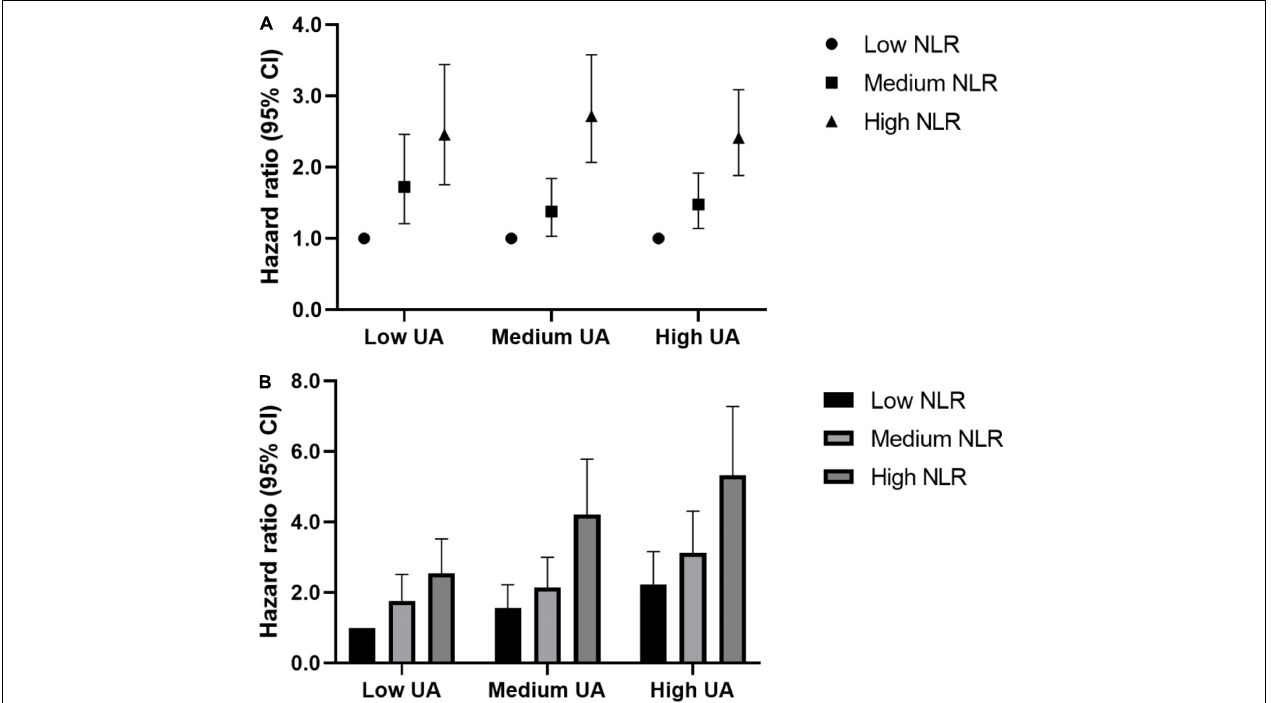
FIGURE 3 | Interaction and joint associations of UA and NLR with ischemic stroke recurrence. Hazard ratios were adjusted for age, gender, hypertension, diabetes, atrial fibrillation, coronary heart disease, HCY, carotid atherosclerosis, TOAST. (A) Multiplicative interaction was evaluated using hazard ratios for the product term between the NLR (low v high) and UA (low v high), and the multiplicative interaction was statistically significant when its confidence interval did not include 1. Additive interaction was evaluated using relative excess risk due to interaction (RERI) between the NLR (low v high) and UA (low v high), and the additive interaction was statistically significant when its confidence interval did not include 0. (B) The highest risks of ischemic stroke recurrence were seen in adults of high SUA and high NLR, which had a 433% increased risk of ischemic stroke recurrence [HR (95%CI): 5.33 (3.91,7.27)], compared to the same reference group (low UA and low NLR). NLR, Neutrophil-to-Lymphocyte ratio; UA, uric